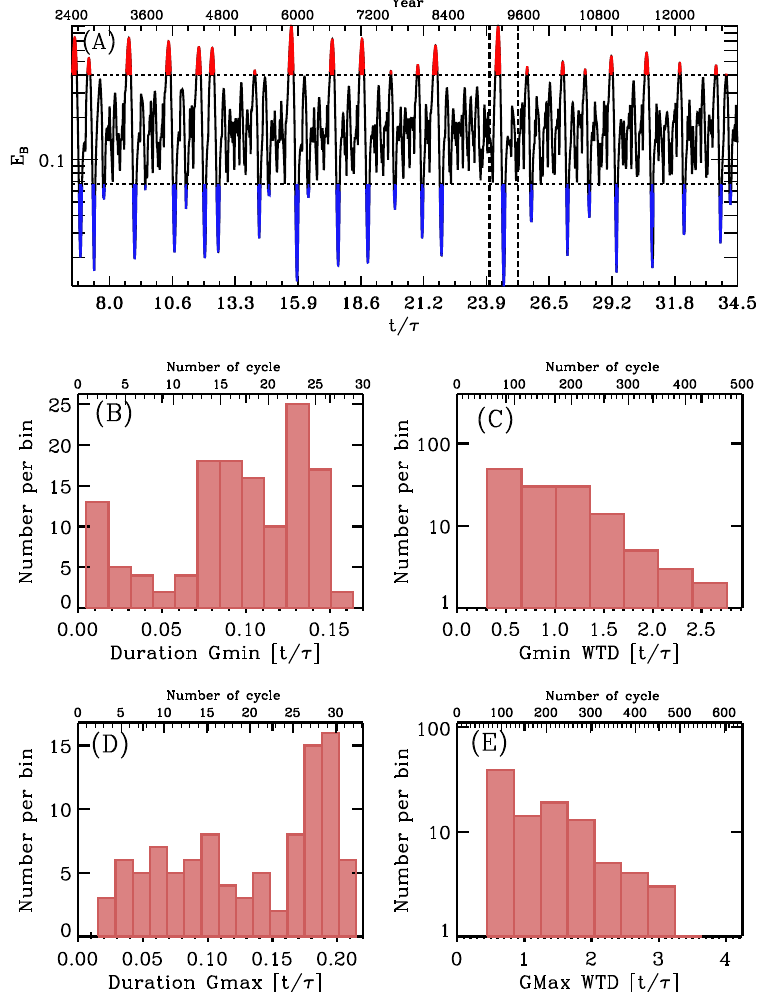
Fig. 12. (A) Time series of total magnetic energy in a 11,000 years segment of a 50,000 years realization of simulation 4. Time is expressed both in units diffusion time (bottom axis) and in years (top axis). The oscillations from the primary cycle have been removed, leaving only the long-term modulation envelope. Epochs of grand maxima and minima are indicated in red and blue, respectively. Compare to Figure 3 in Usoskin et al. (2007). The vertical dashed lines delineate the time interval spanned by Figure 8. The four other panels show histograms of (B) Grand Minima durations, (C) waiting times between successive Grand Minima, (D) Grand Maxima durations, and (E) waiting times between successive Grand Maxima (see